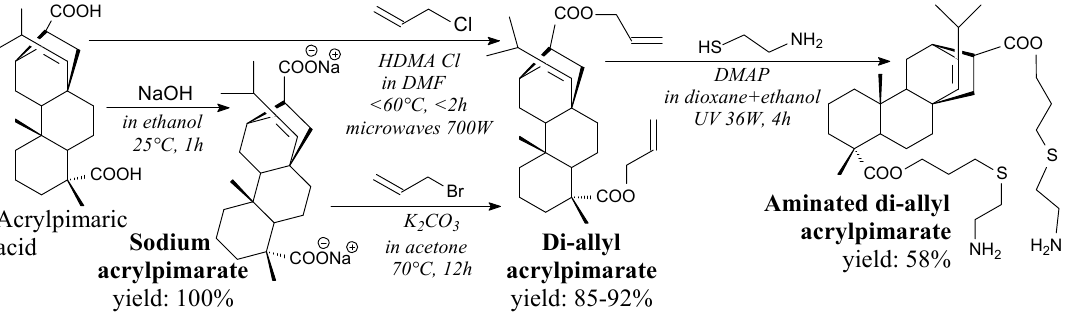
Scheme 17. Synthesis of diallyl acrylpimarate and its aminated derivative.